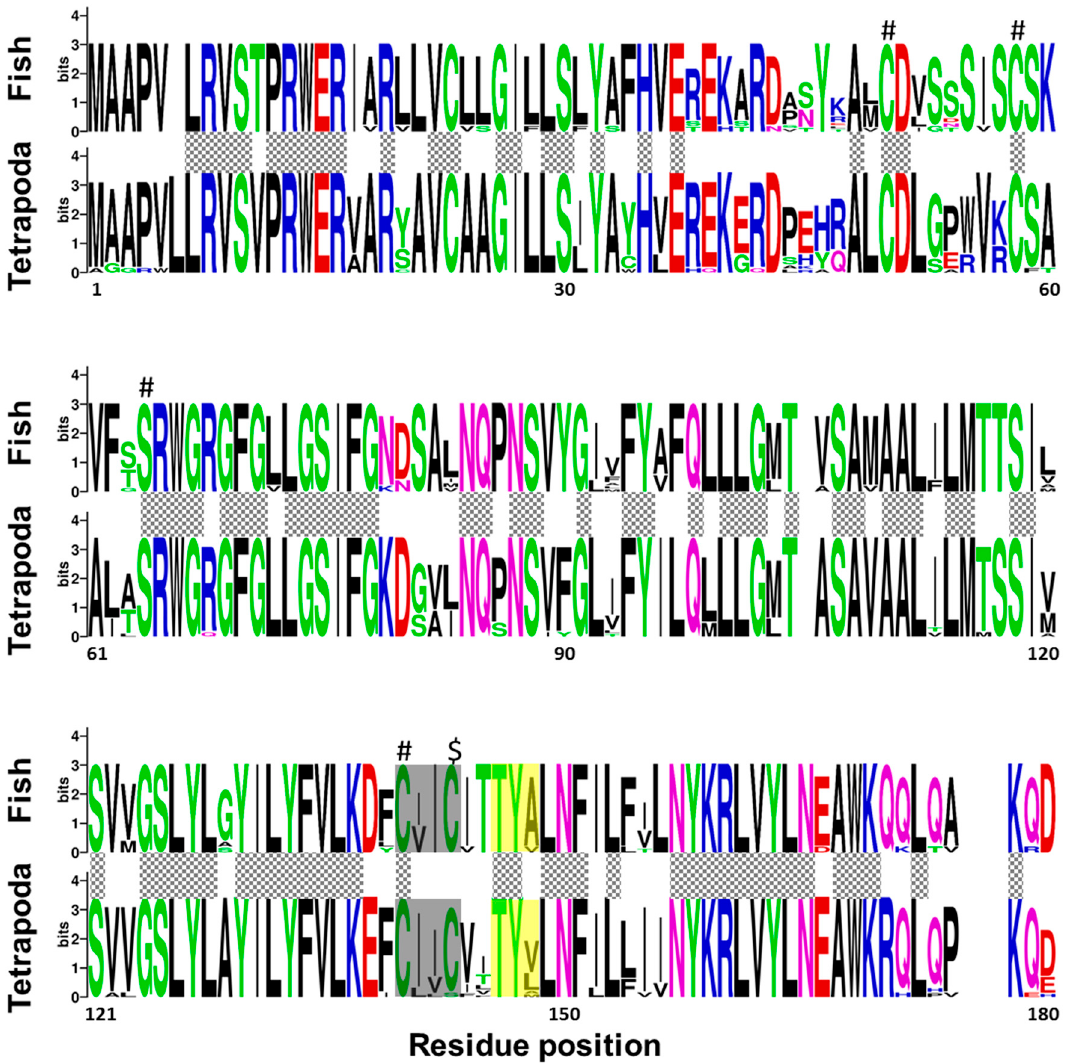
Figure 3. Conservation of amino acid residues in vitamin K epoxide reductase complex subunit 1 like 1 (Vkorc1l1) between fish and tetrapods. Logos were constructed from isoform-specific alignments of mature peptides. The height of the letters is directly proportional to their frequency. Please, note that: Hashes indicate Vkor active sites (three cysteines and serine); dollar symbol, indicates the non-fully conserved Vkor active site (a cysteine); yellow box, warfarin binding motif (TYX); grey box, the known hydrophobic environment of the thiol redox site of the enzyme; grey squared boxes between alignments, amino acids with full conservation between both taxa: fish and tetrapoda.